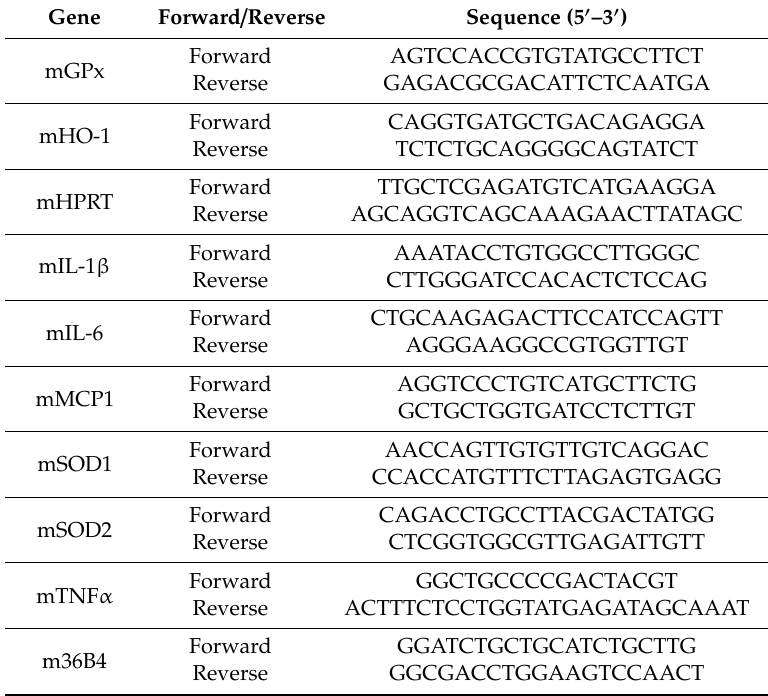
Table 1. Primer sequences for